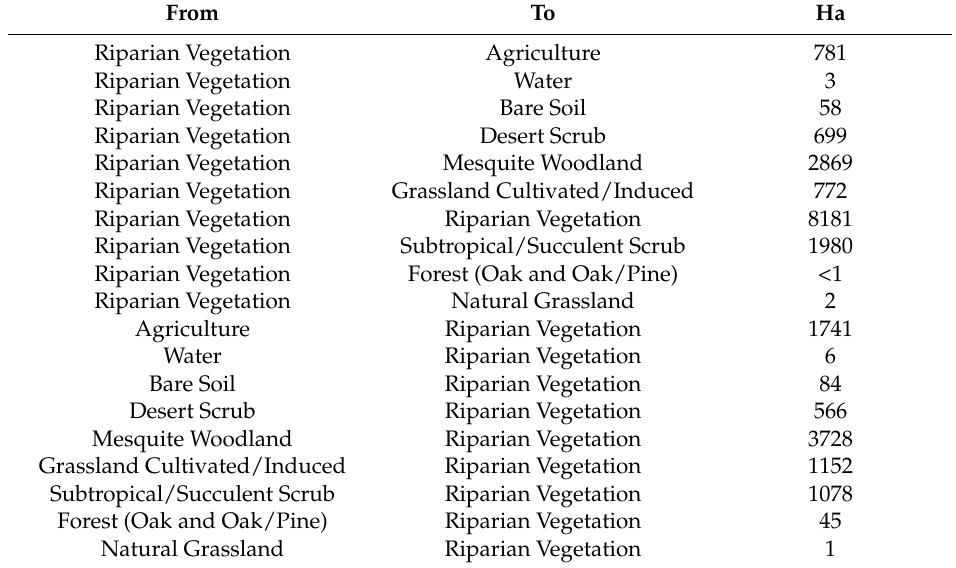
Table 10. Changes in Riparian Vegetation related to Water depth greater than seven meters (changes from 2002 to